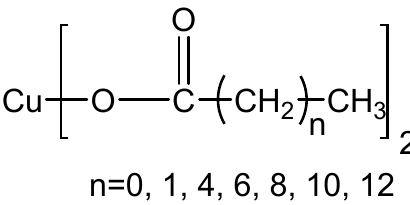
Figure 1. Chemical structure of starting reagents with different alkyl chain lengths.